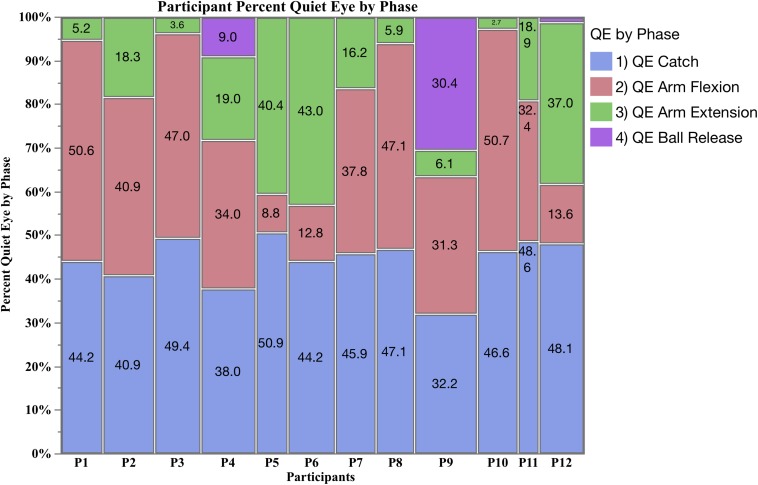
Mosaic plot of the percent of QE fixations for each participant by phase (QE catch, QE arm flexion, QE arm extension, and QE ball release).